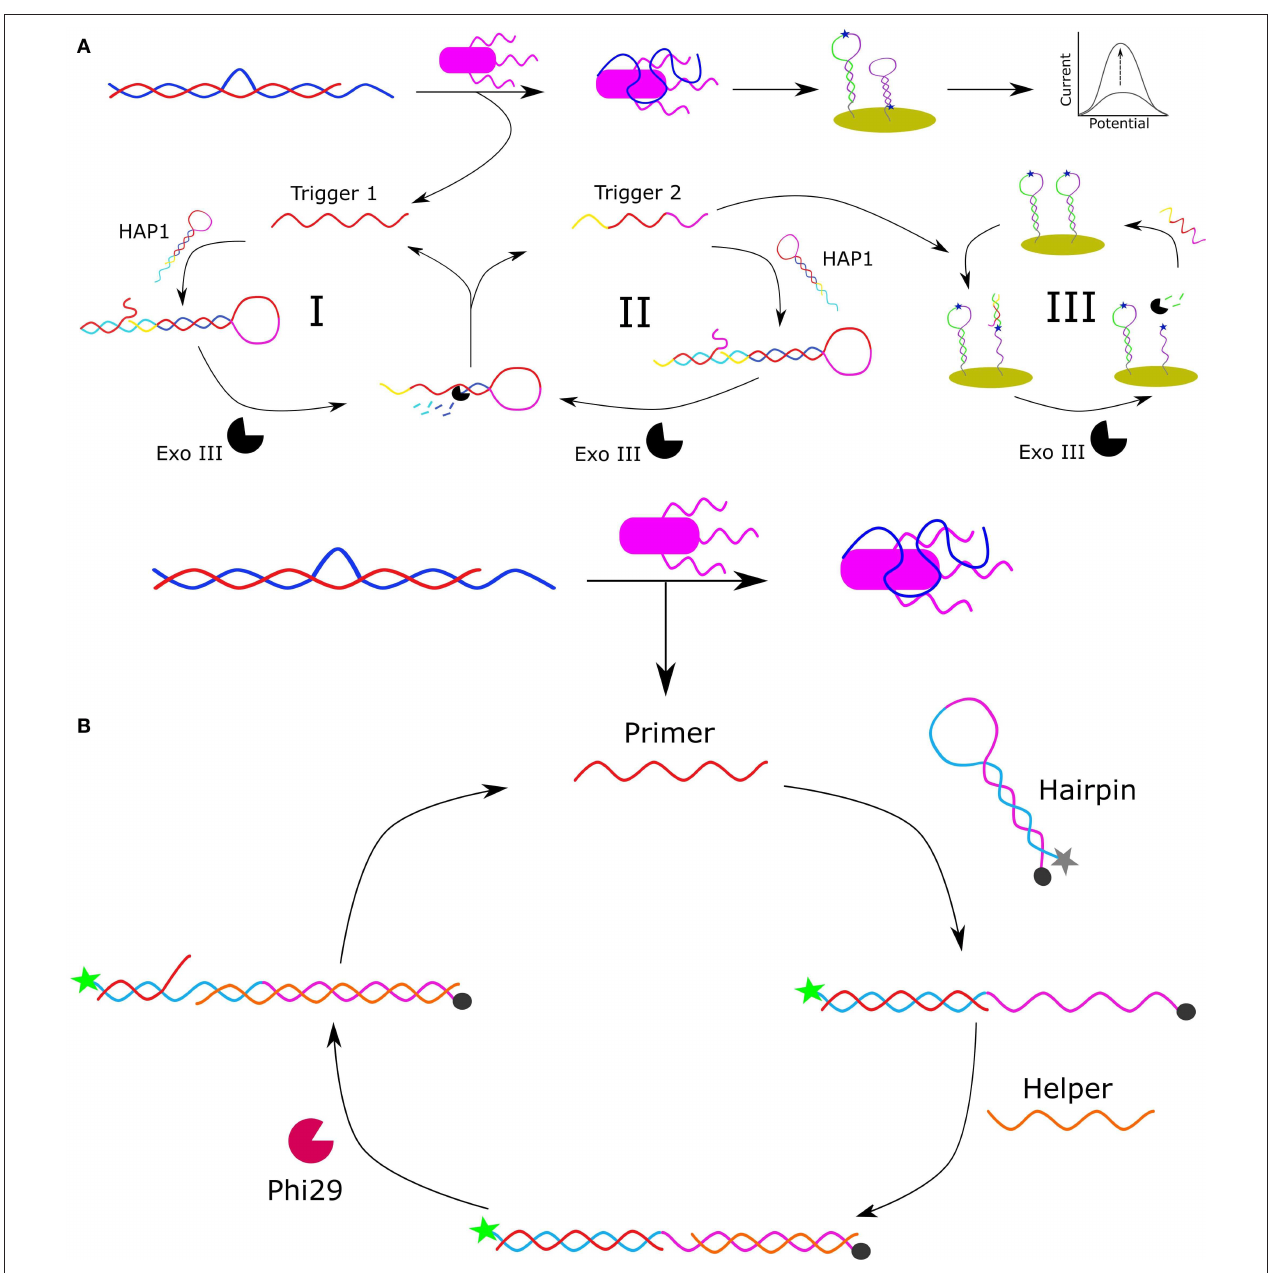
FIGURE 1 | Schematic representation of apatmer-based electrochemical detection of S. typhimurium based on Exo III-assisted multiple signal amplification (Pei et al., 2019) (A) . Schematic representation of the FRET-based detection of S. paratyphi using a specific aptamer and Phi29-DNA polymerase-assisted cyclic signal amplification (Liang et al., 2019) (B)